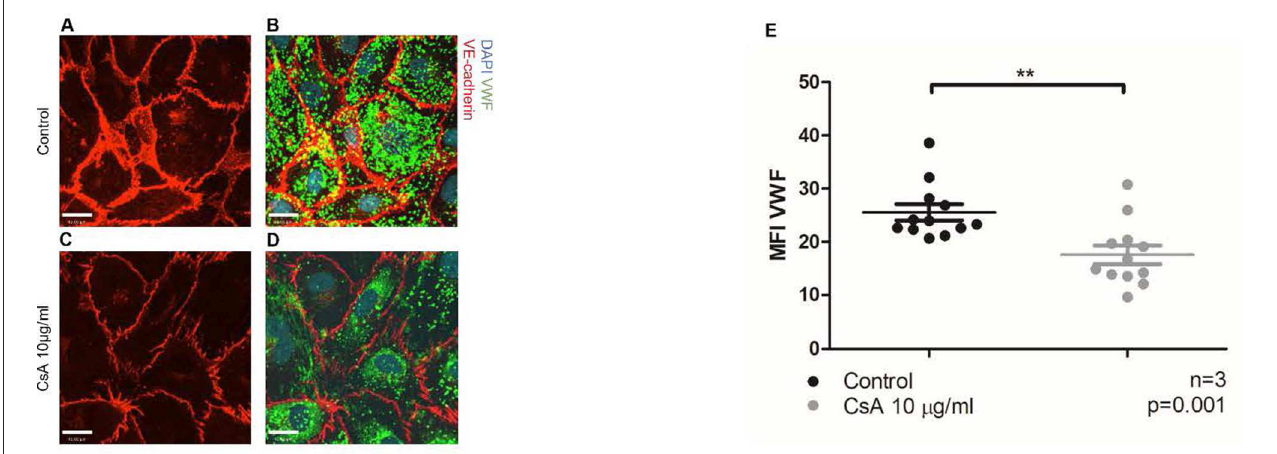
FIGURE2 Cyclosporine causes endothelial cell release of Weibel–Palade bodies and its contents. (A–E) Von Willebrand factor (VWF) release from blood outgrowth endothelial cells (BOECs) was detected via immunofluorescence. Control BOECs were treated with media for 24h. The experimental condition was with BOECs treated with cyclosporine (CsA) 10 µ g/ml for 24h. BOECs were fixed with 2% paraformaldehyde and permeabilized with 0.2% Triton in phosphate-buffered saline, followed by incubation with rabbit anti-VWF (1:1,000) and goat anti-VE-cadherin (1:250) for 4h. Alexa Fluor 488 (green)- and 555 (red)-conjugated species-specific secondary antibodies were used at dilution of 1:1,000. Nuclei were stained with 0.12 µ g/ml Hoechst stain for 5min. Images were taken using an IX81 inverted microscope (Olympus Corp., Tokyo, Japan) with a 60/1.35 oil immersion objective and a C9100-13 back-thinned EM-CCD camera (Hamamatsu Photonics, Hamamatsu City, Shizuoka Pref., Japan) with a CSU X1 spinning disk confocal scan head (Yokogawa, Yokogawa Canada Inc., AB). Bar = 22 µ m. Treatment with cyclosporine 10 µ g/ml for 24h led to less intracellular VWF and less intense staining of VE-cadherin (A–E) ( n = 3, ** p = 0.001, two-tailed t